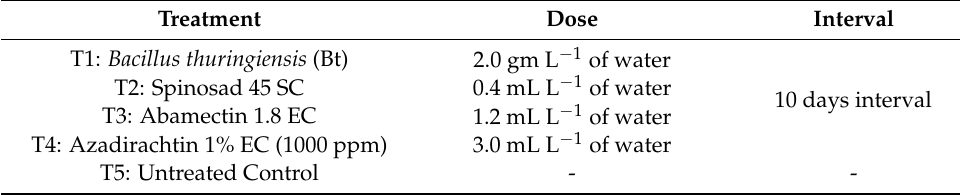
Table 1. Treatments and components of this experiment. Treatment Dose